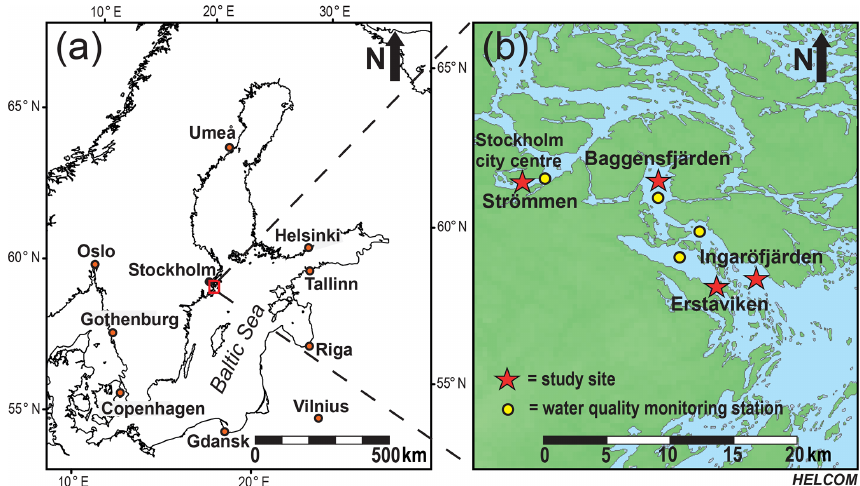
Figure 1. The Baltic Sea (Ning et al., 2016), with the study area in the Stockholm archipelago indicated by the red box (a) . Detailed map of the southwestern part of the inner and intermediate Stockholm archipelago (see Almroth-Rosell et al., 2016). Red stars indicate the locations of the study sites: Strömmen, Baggensfjärden, Erstaviken and Ingaröfjärden. Yellow dots indicate the locations of the water quality monitoring stations (SMHI, 2019) most proximate to the sites in this study (b)